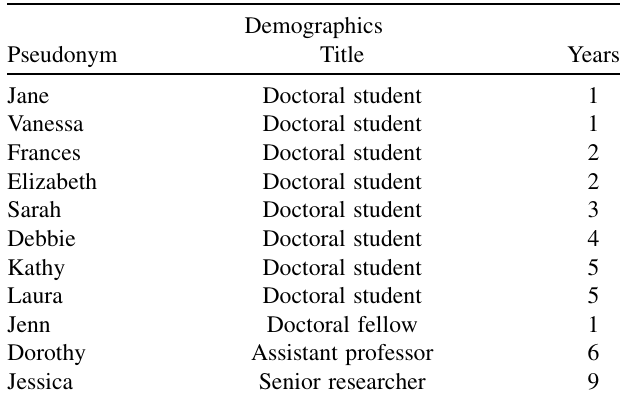
TABLE I. Sample demographics including pseudonym, career stage, and years at current career